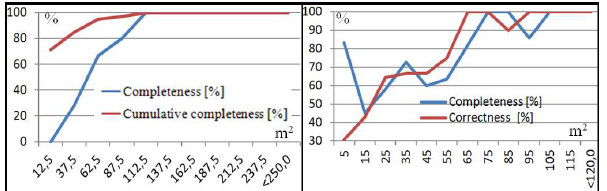
Figure 8: Left: Completeness and cumulative completeness of the building detection results (correctness values are not shown because they are all 100%) for the data set Vaihingen . The blue curve shows the completeness for buildings having an area indi- cated on the abscissa; the red curve shows the completeness for all buildings having a larger area than the one shown in the ab- scissa. Right: Completeness and correctness of the roof planes as a function of the area covered by a